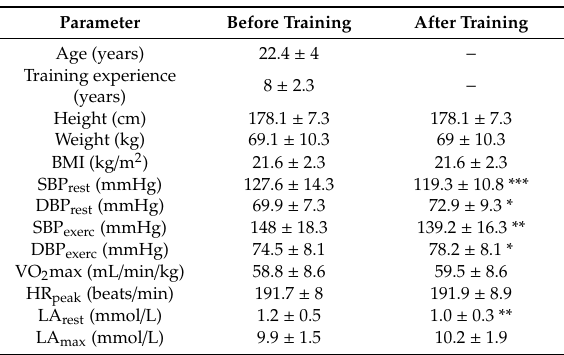
Table 1. Basic characteristics of the studied